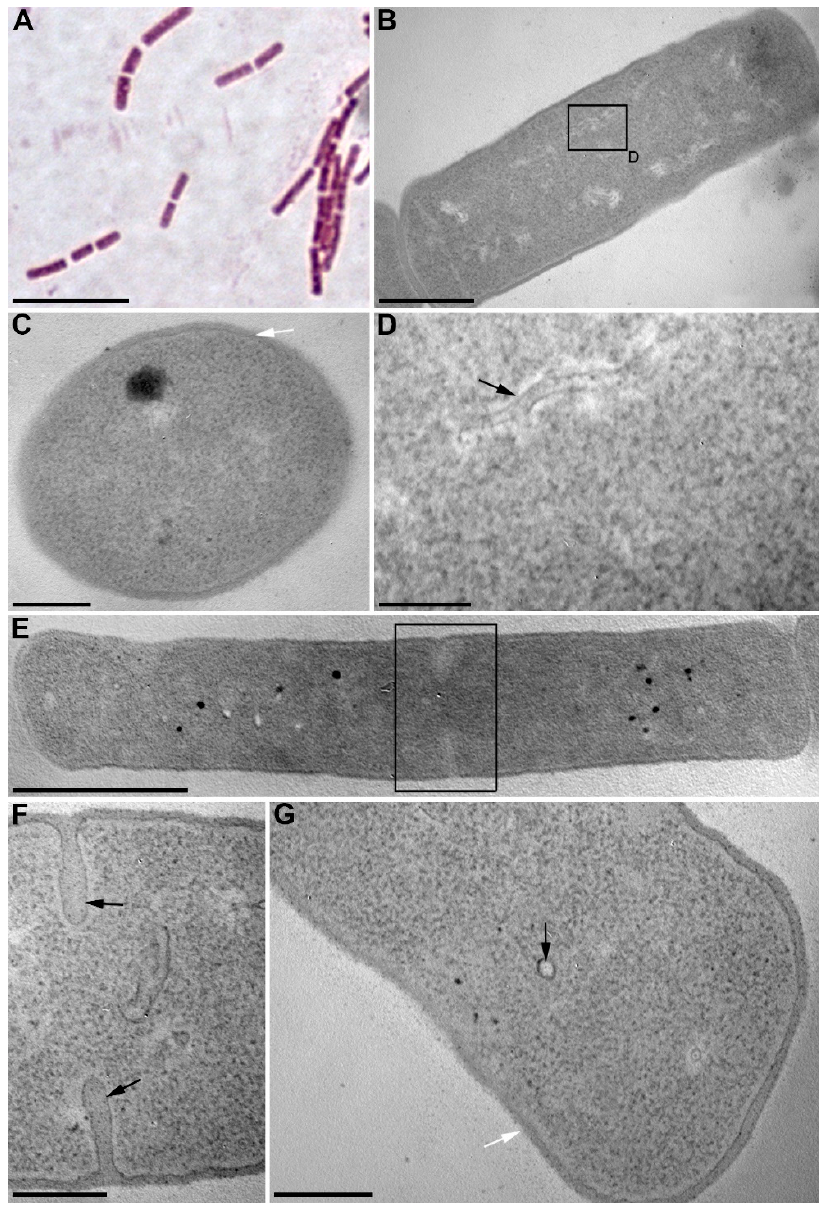
Figure 1. Cells of B. mycoides BS2-15. ( A ) fluorescent microscopy; ( B – G ) transmission electron microscopy: ( B ) longitudinal section of a B. mycodies cell; ( C ) cross-section of a B. mycoides cell; ( D ) a fragment of Figure 1B showing the long curving structure in the cytoplasm; ( E ) a longitudinal section of a dividing cell; ( F ) a fragment of Figure 1E, septae are marked by the arrows; ( G ) a fragment of Figure 1E; black arrow marks a circular structure in the cytoplasm, white arrow marks the cell wall. Scale bars: ( A ) 5 μ m; ( B ) 500 nm; ( C , F , G ) 200 nm; ( D ) 100 nm; ( E ) 1 μ m.